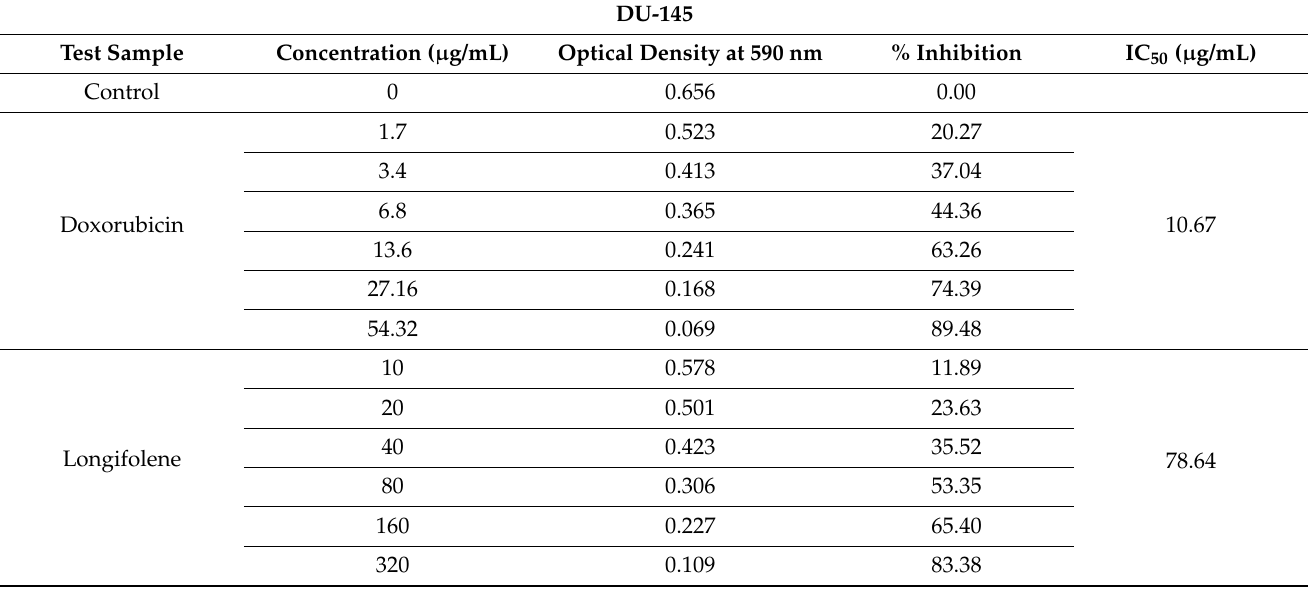
Table 1. MTT assay of doxorubicin and longifolene on DU-145.